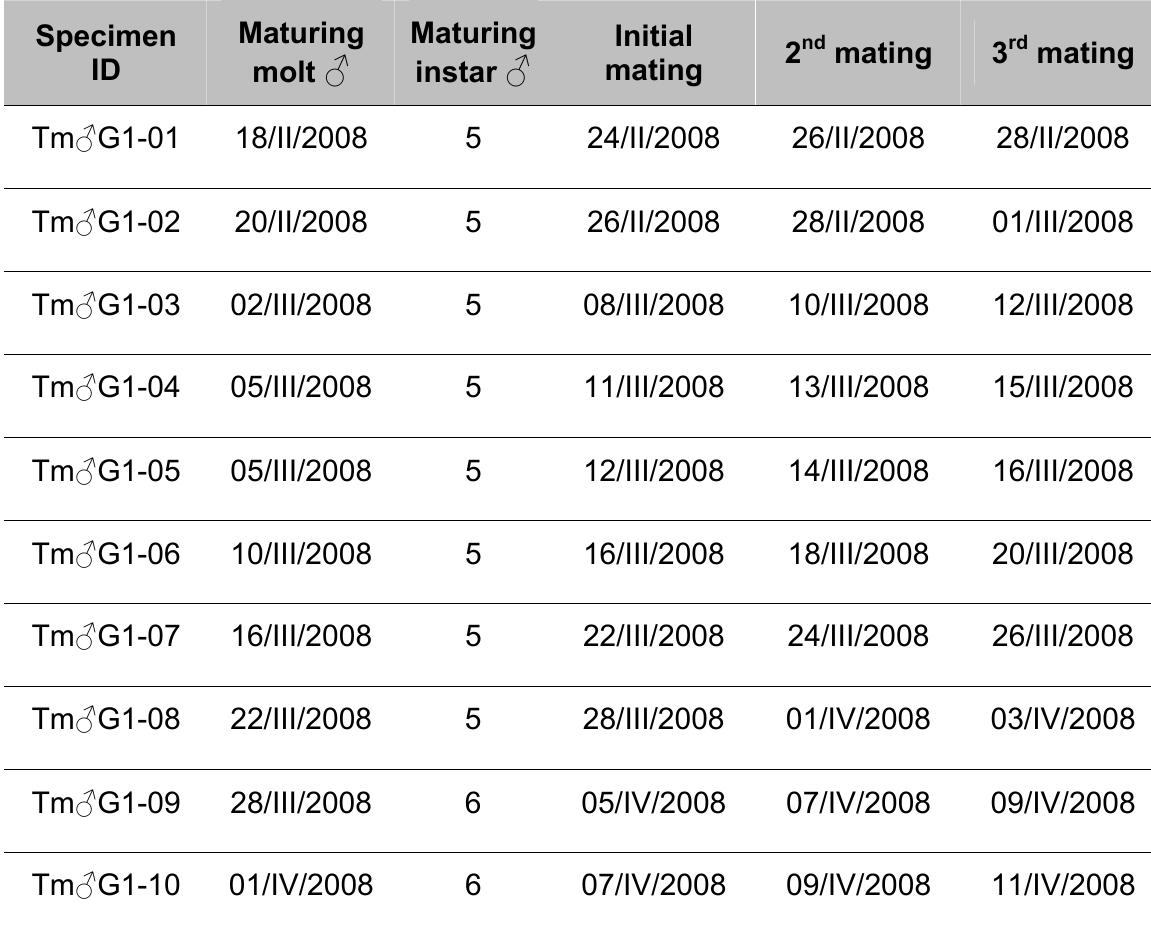
Table 1. Spermatophore production and regeneration time in ten males of Tityus ( Atreus ) magnimanus